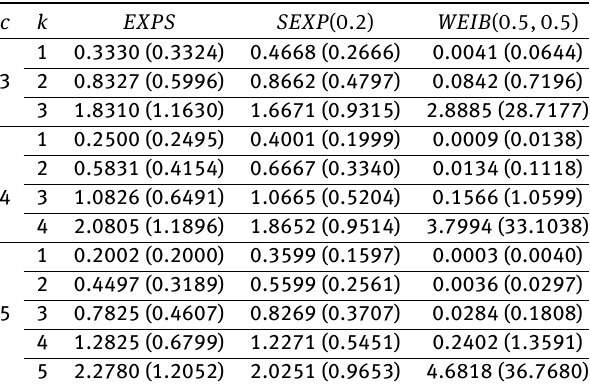
( σ S ) for ( c , k ) systems when µ = S